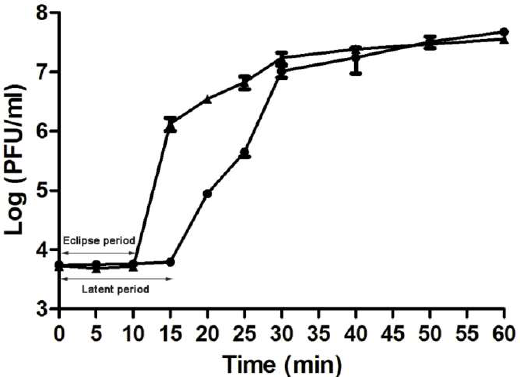
Figure 1. The morphology of vB_AviM_AVP (AVP). AVP was negatively stained with 2% phosphotungstic acid (PTA) and examined by transmission electron microscopy (TEM) at an accelerating voltage of 80 kV. The scale bar represents 100 nm.